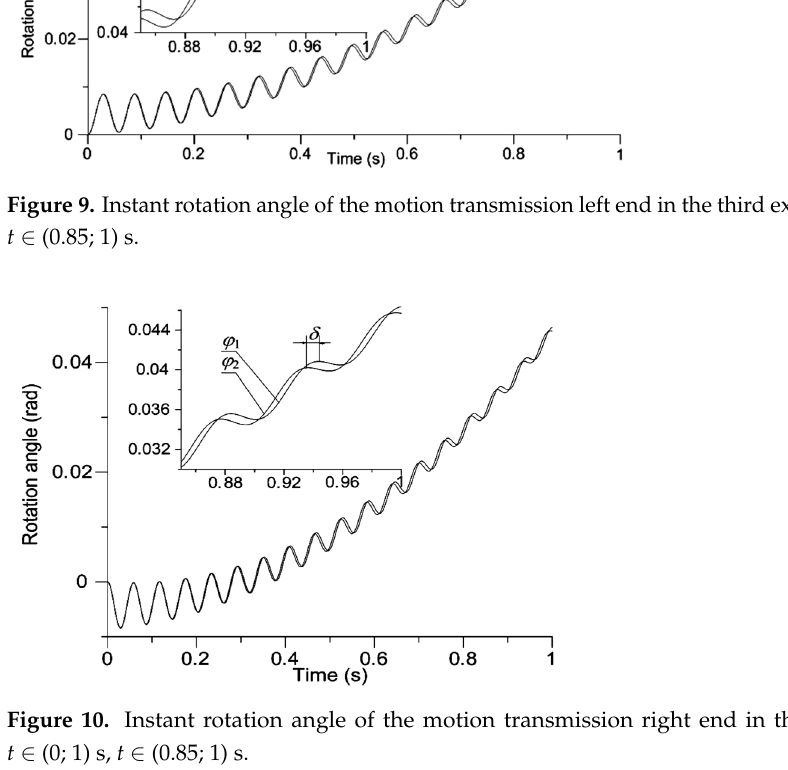
Figure 10. Instant rotation angle of the motion transmission right end in the third experiment t ∈ (0; 1) s, t ∈ (0.85; 1) s.